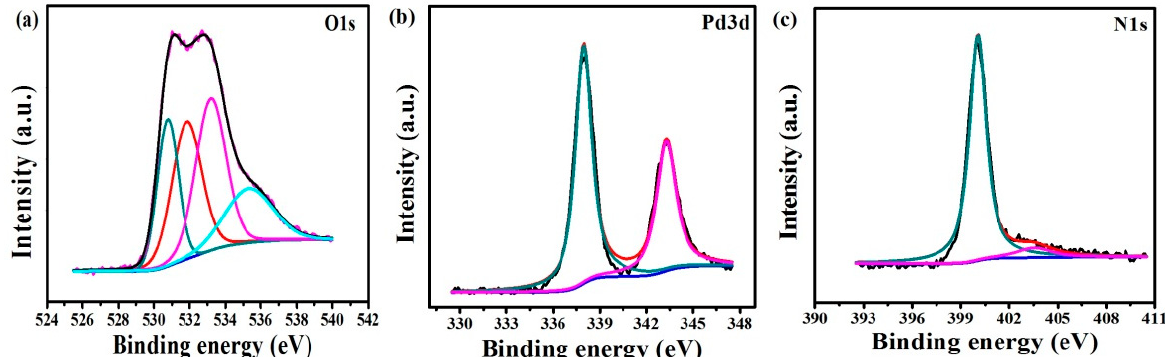
Figure 2. XPS ( a ) O1s, ( b ) Pd3d and ( c ) N1s spectra of Pd2+/COFs.